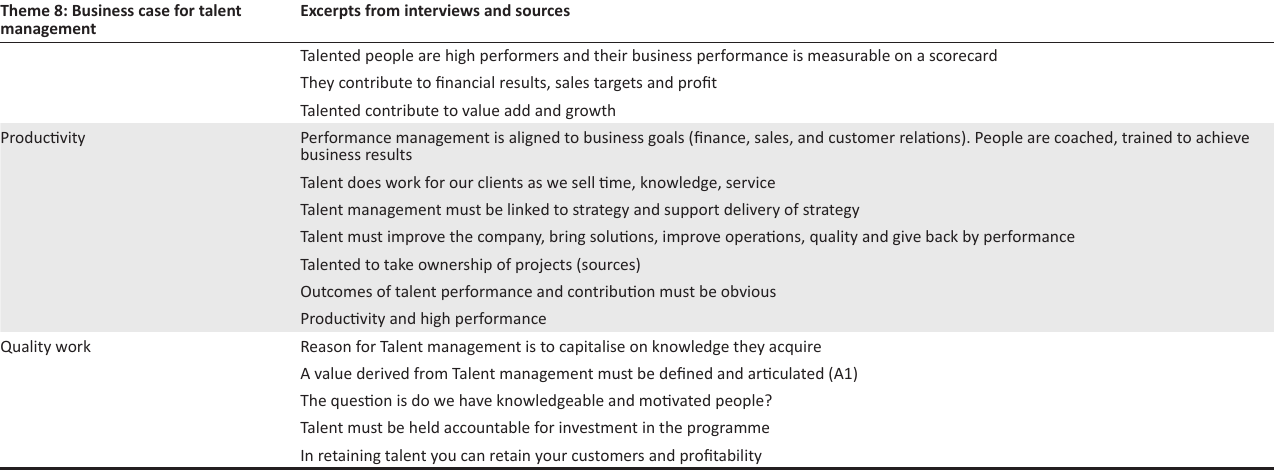
TABLE 8 (Continues...): Business case for talent